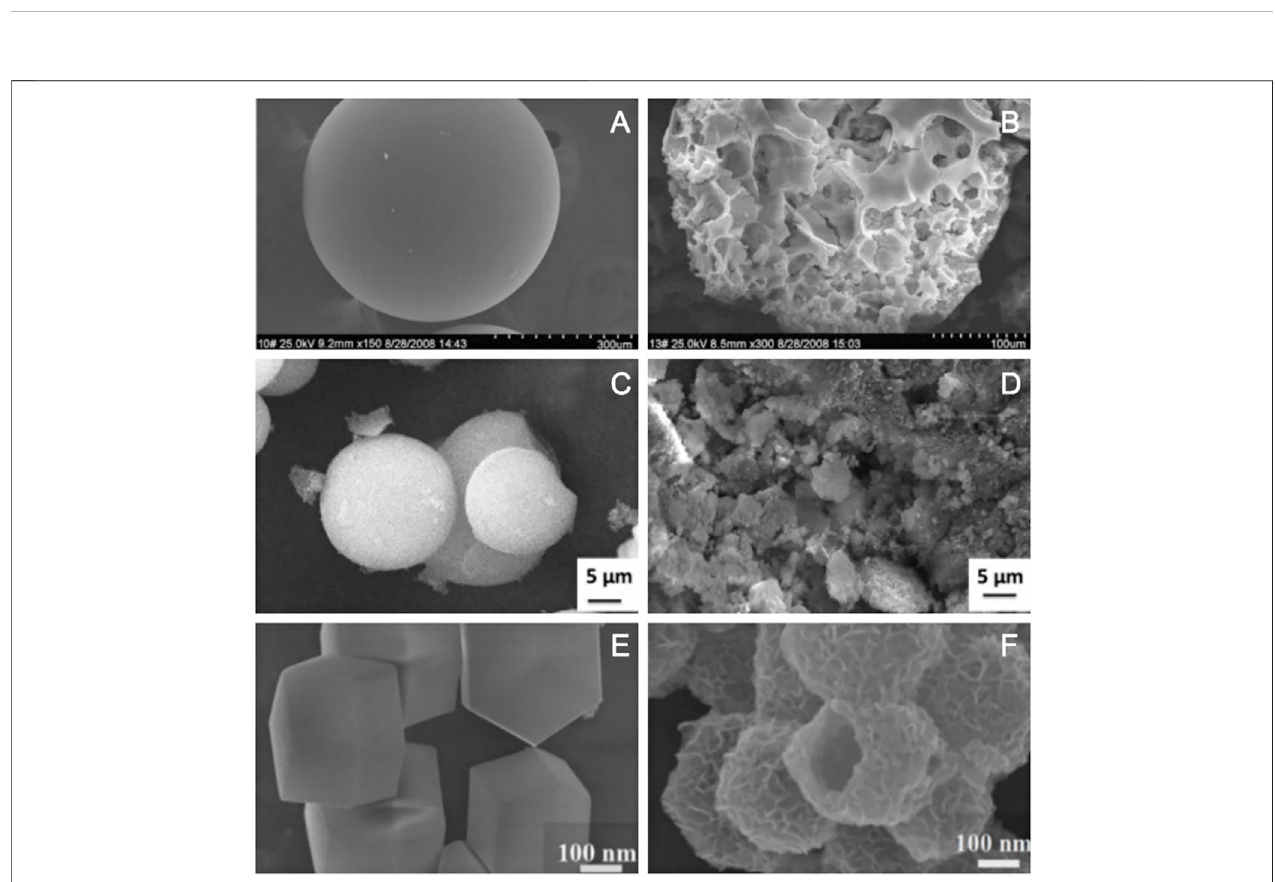
FIGURE 6 | SEM images of D311 resin (A) and PCTOM (B) (Zhang et al., 2011); SiO 2 (C) and Fe 2 O 3 /SiO 2 composite monoliths (D) (Singh et al., 2018); ZIF-67 (E) and NiCo-LDH (F) (Hu et al., 2019).